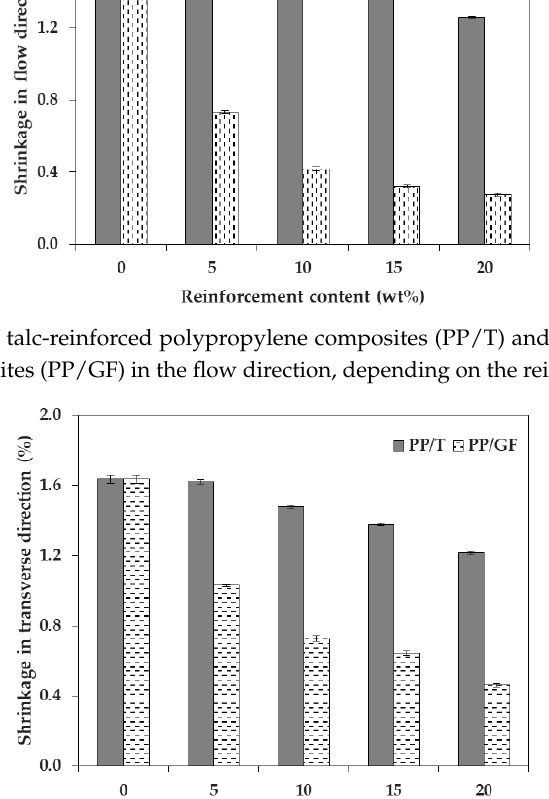
Figure 4. Shrinkage of PP/T and PP/GF in the thickness direction, depending on reinforcement type.